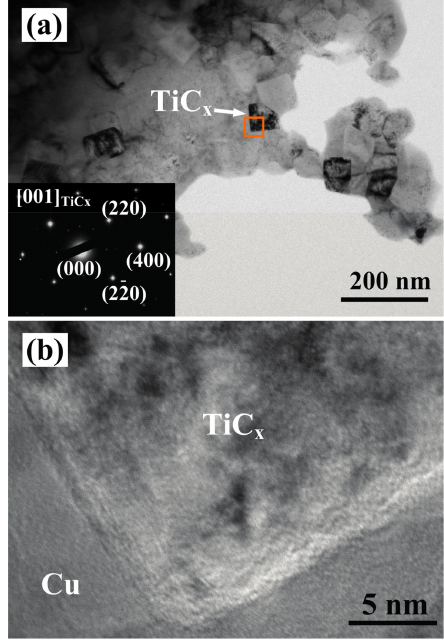
Figure 6. ( a ) TEM images of composite 1 and ( b ) enlarged image of the marked area of composite 1.